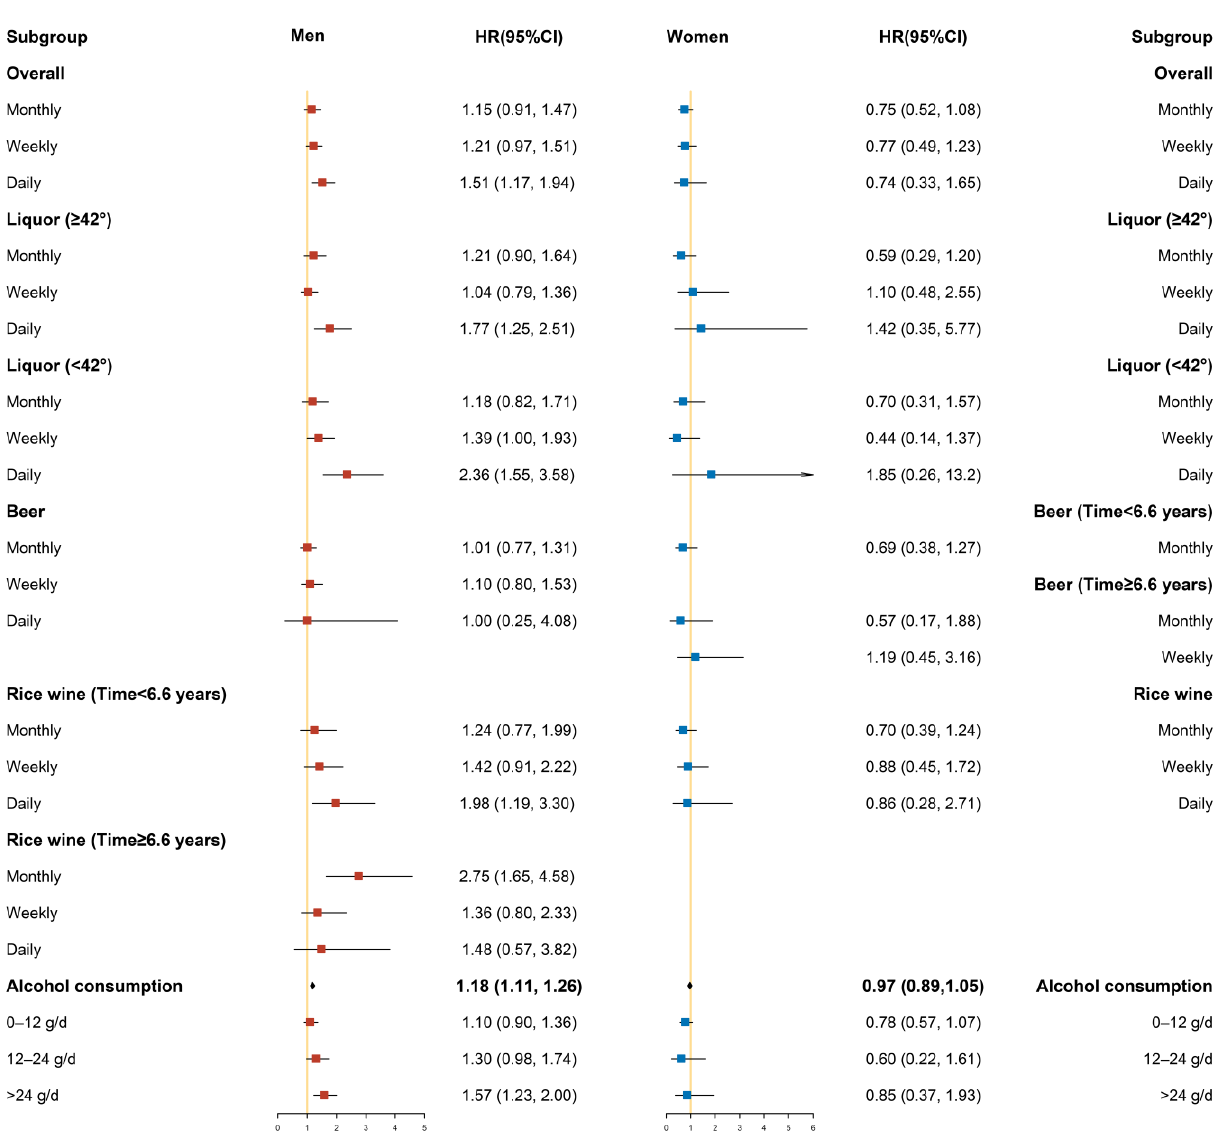
Figure 1. Subgroup analysis after stratification by gender (Model 3).